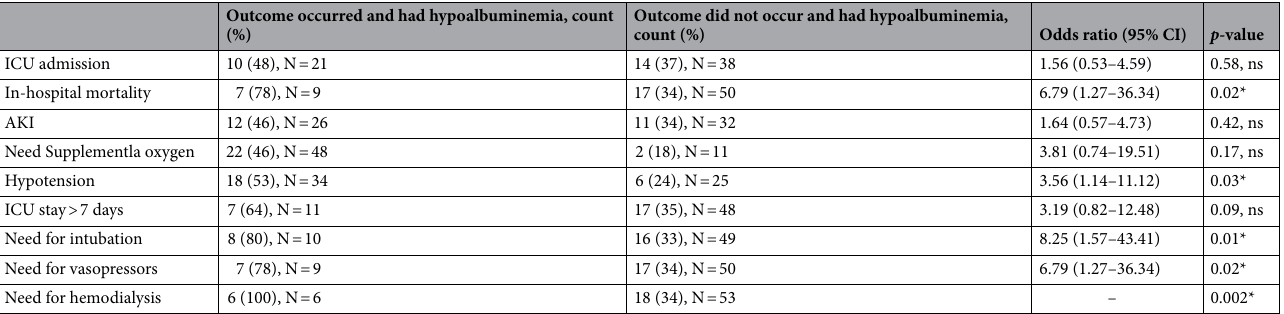
Table 2. The prognostic significance of hypoalbuminemia as it relates to multiple clinical outcomes of Covid- 19 disease severity. Fishers Exact Test was used to make comparisons between groups, with a p < 0.05 indicating significance. Data presented as counts of total population, N , with the respecitve outcome; percentages indicate those who had hypoalbuminemia of total population who did or did not have outcome. AKI acute kidney injury, CI confidence interval, ICU intensive care unit, ns